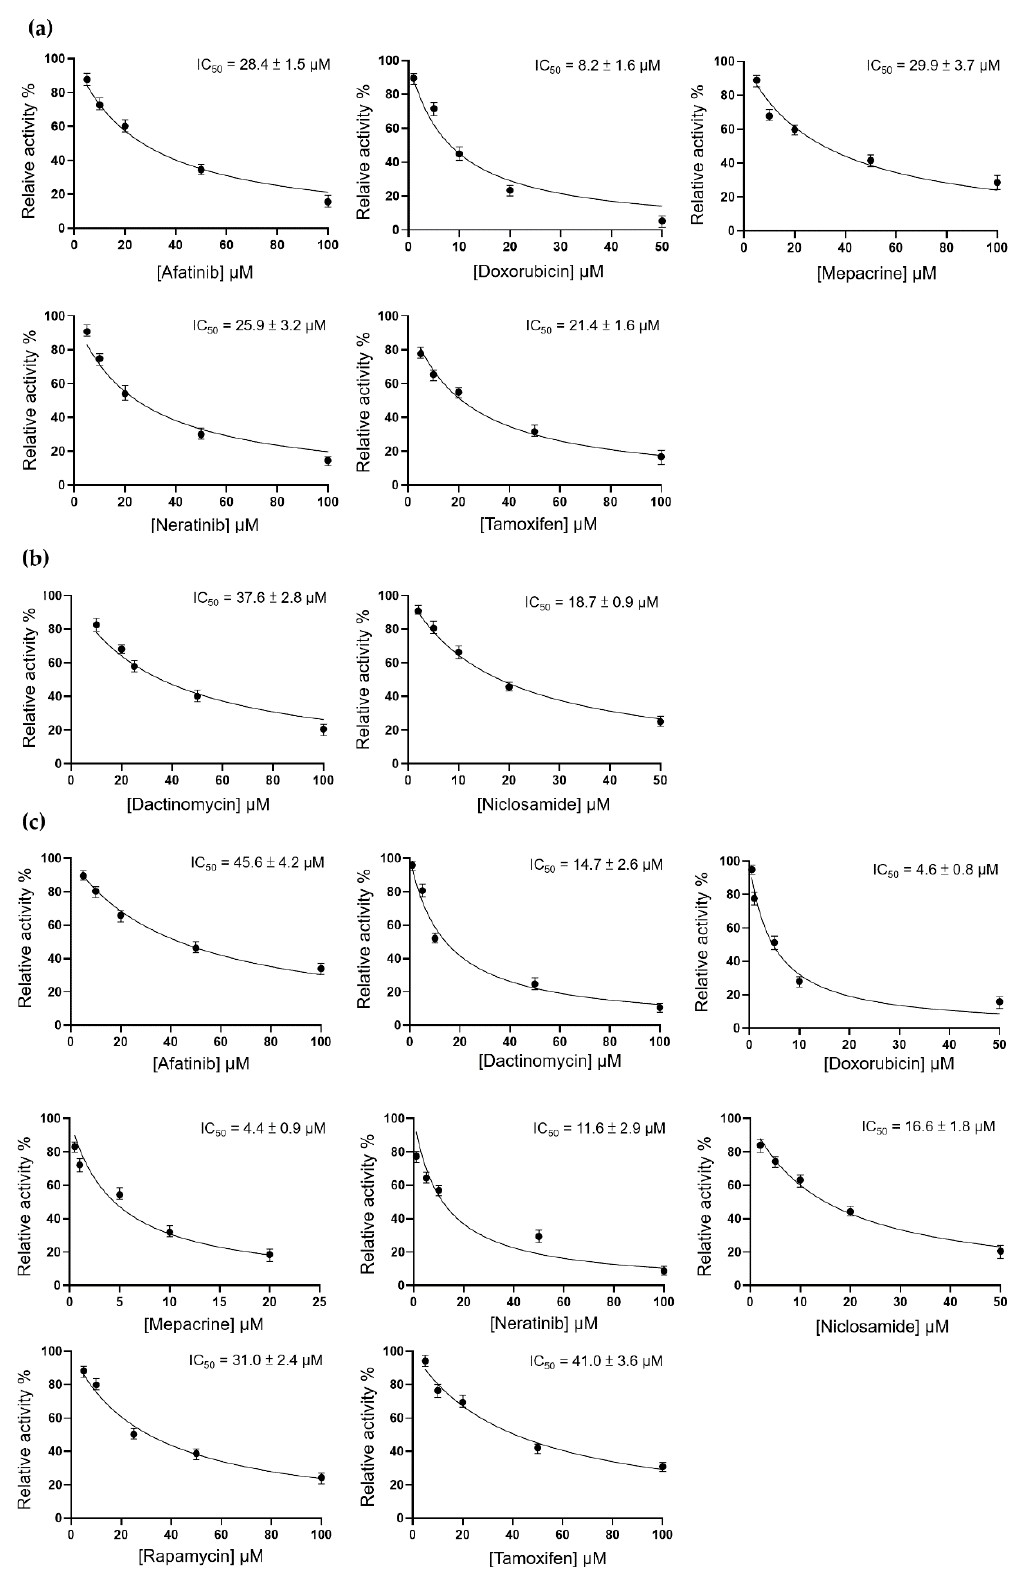
Figure 5. Inhibition assay for TMPRSS2, 3CL pro , and PL pro . ( a ) TMPRSS2 enzyme activity was measured using the following equation: A(I) = A(0) × {1 − [I/(I + IC 50 )]}. ( b ) 3CL pro enzyme activity was calculated with the Michaelis–Menten equation. ( c ) PL pro enzyme activity was calculated with the Michaelis–Menten equation.